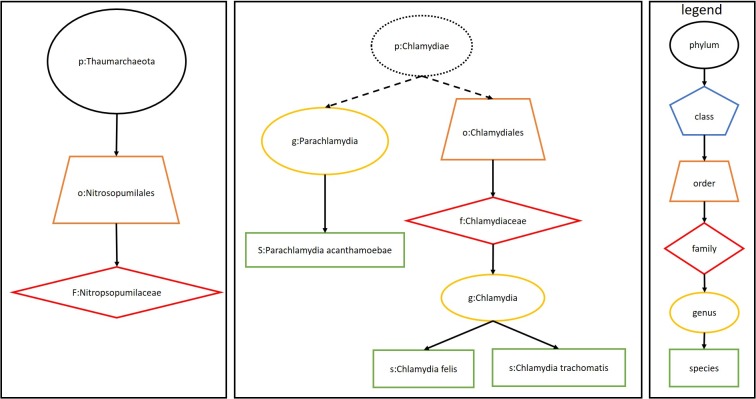
Lower taxa identified from the phyla Thaumarchaeota and Chlamydiae.Only taxa from the last column of Table 1 are shown. Note that no class from these two phyla are identified in the last column of Table 1. The phylum Chlamydiae is presented in a dotted box, as it is not identified in the last column of Table 1.